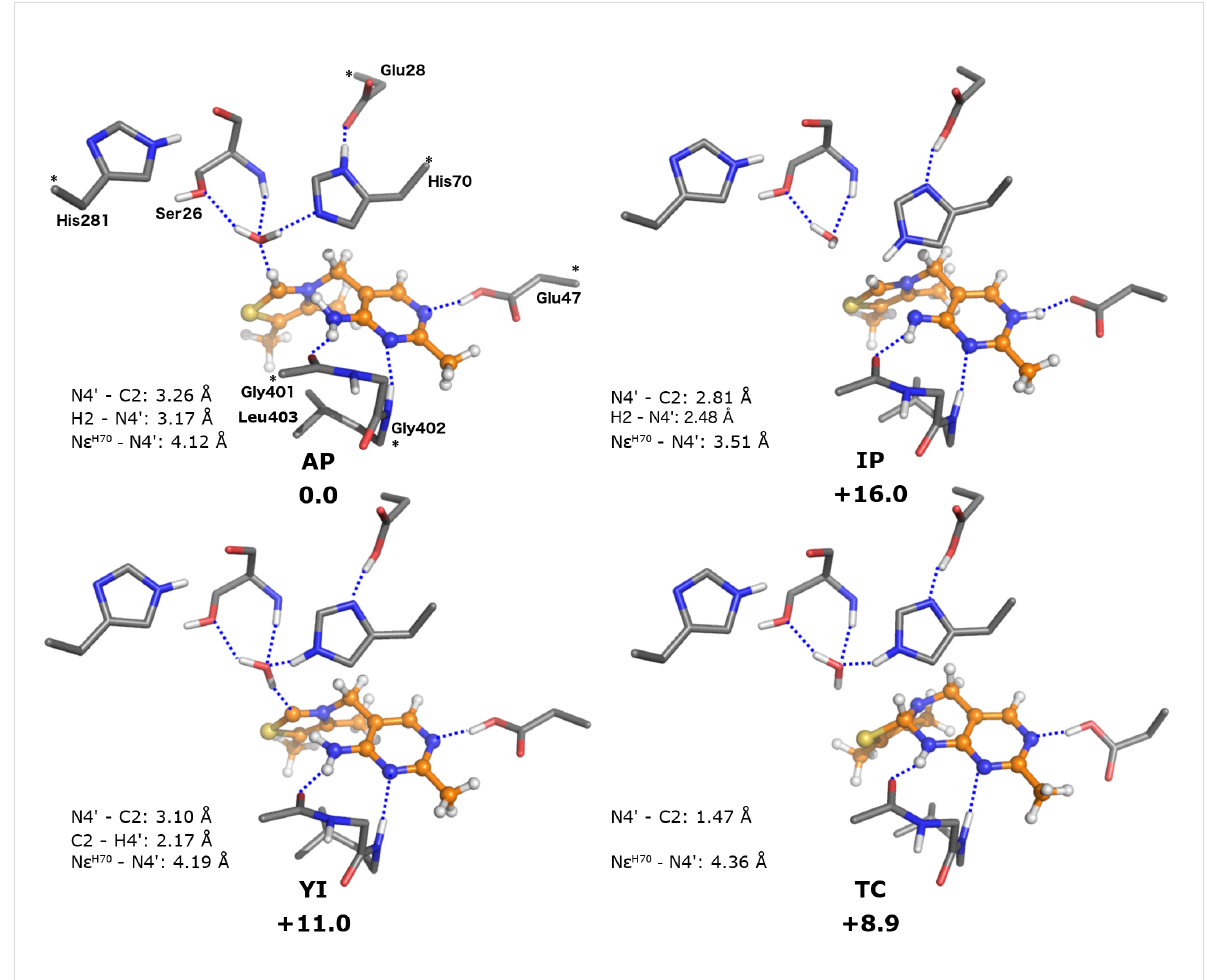
Figure 4: Optimized structures of the ThDP states for the model including the crystallographic water (model C ). Relative energies are indicated in kcal/mol.